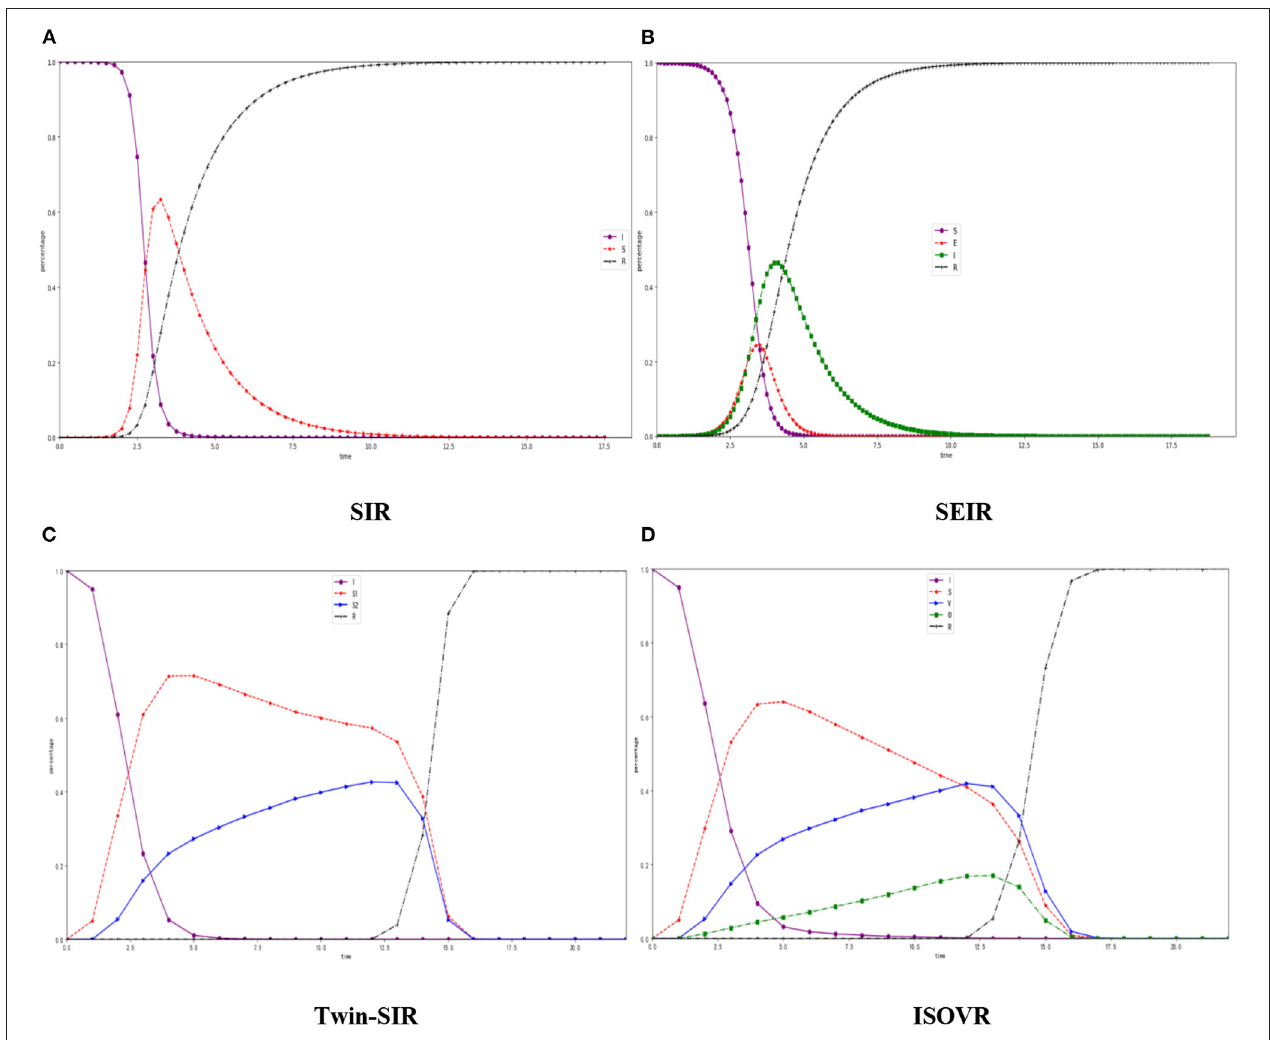
FIGURE 4 | Susceptible Infected Recovered (SIR) model, SEIR model, Twin-SIR, model and ISOVR model in the BA net scale-free network . (A) SIR, (B) SEIR, (C) Twin-SIR, (D)